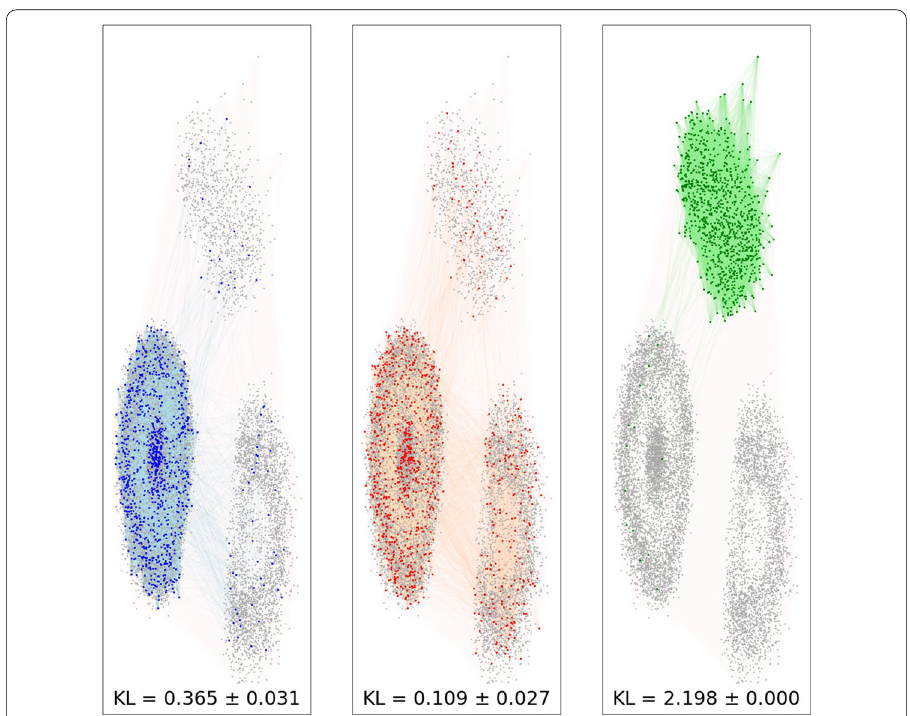
Fig. 12 Results of sampling on assortative SBM with different block sizes. Sampled nodes and edges are colored in blue for TCEC (left), red for uniform random walk (center) and green for expansion sampling (right). The KL-divergence averages and standard deviations are computed over 10 different rounds of sampling 10% of all the nodes